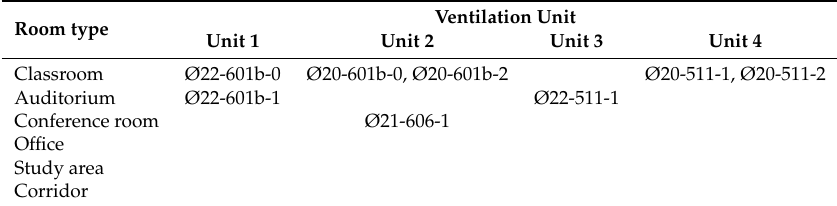
Table 4. Room flagged as anomalous in both experiments conducted.